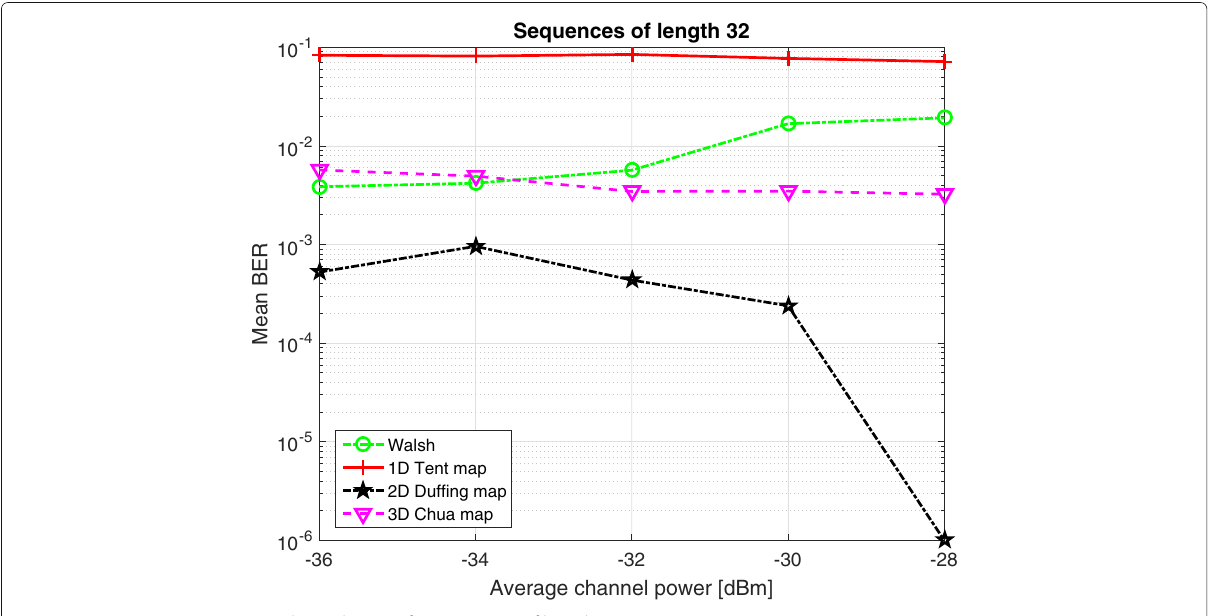
Fig. 8 Mean BER against average channel power for sequences of length 32